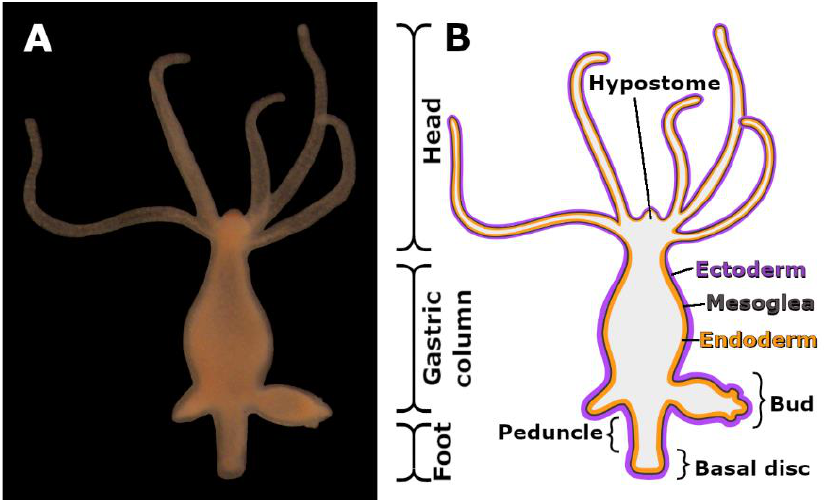
Figure 1. ( A ) Picture and ( B ) morphological scheme of an adult asexually reproducing Hydra polyp. Here, we characterize the glycan composition of the Hydra adhesive material, using a set of 23 commercially available lectins. We applied the lectins to label Hydra tissue, including whole-mount animals and macerated basal disc cells, and the secreted footprints. Overall, eight lectins detected the footprints left behind on the substrate, indicating the presence of N-acetylglucosamine, N-acetylgalactosamine, fucose, and mannose in the adhesive material. The secreted adhesive appeared fibrillar and formed a dense meshwork, with an accumulation of material at the cell borders of the formerly attached basal disc